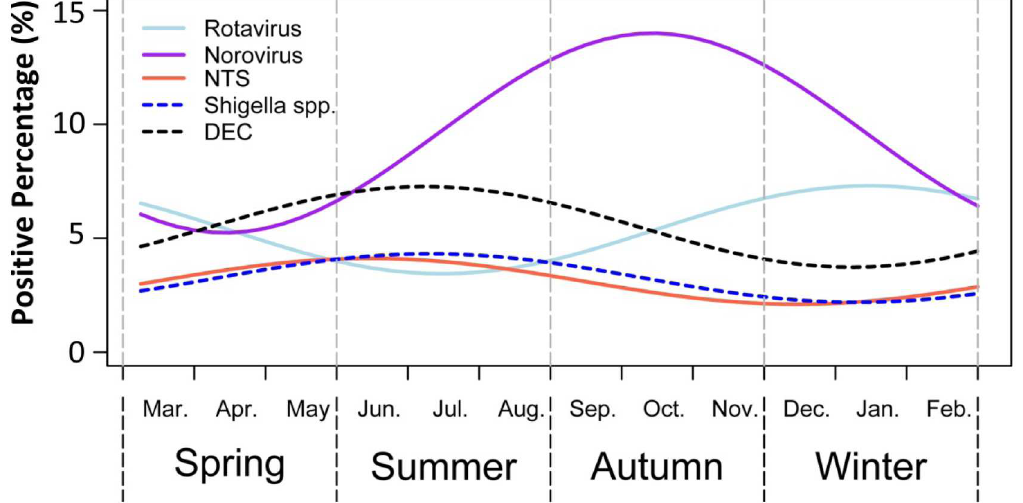
Fig 2. Seasonal pattern of predominant enteropathogens in the elderly with acute diarrhea in China, 2009– 2014. DEC = Diarrhea-genic Escherichiacoli; NTS = Non-typhoidal Salmonella spp.